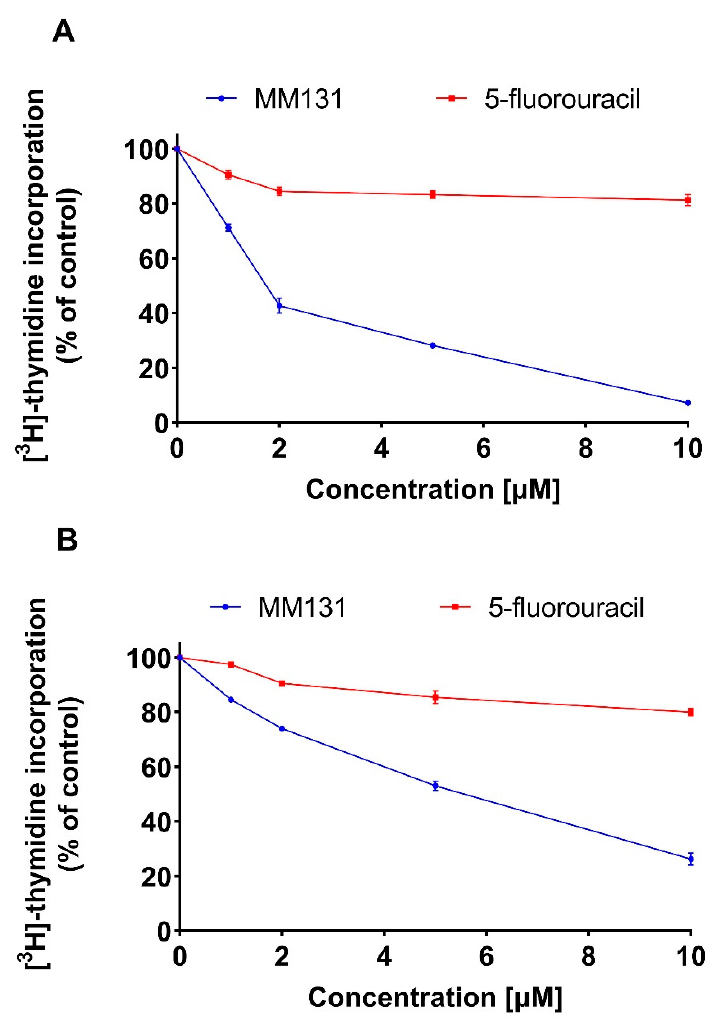
Figure 2. [ 3 H]-thymidine incorporation assay was used to assess the anti-proliferative effect of MM131 and 5-fluorouracil against DLD-1 ( A ) and HT-29 ( B ) cells at different concentrations (1– 10 µM) at 24 h of incubation. The results are presented as a percentage of untreated cells (± SEM, n =